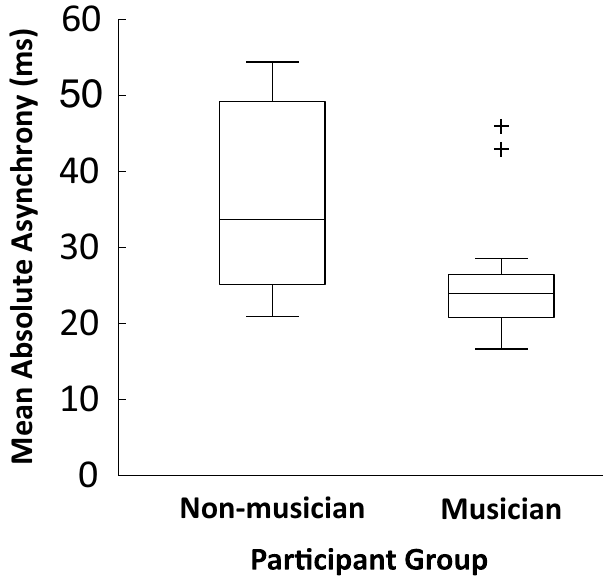
Figure 2. Mean absolute asynchrony values (ms) by participant group in the Duet performance task. Top and bottom whiskers indicate minimum and maximum values,